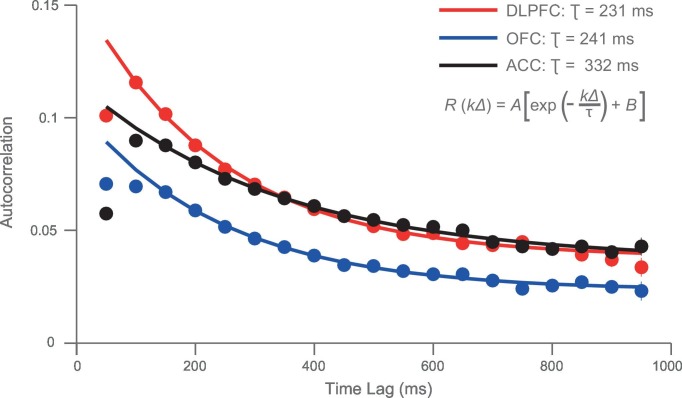
Autocorrelation structure of the DLPFC, OFC and ACC populations.Time constant (tau parameter from the displayed equation), captures the maintenance of autocorrelation over time. ACC had the highest time constant of all regions studied. See also Figure 2—figure supplement 3 for autocorrelation when trials were filtered for drifting firing rate (see Materials and methods) and Figure 2—figure supplement 4 for population autocorrelation across trial time.